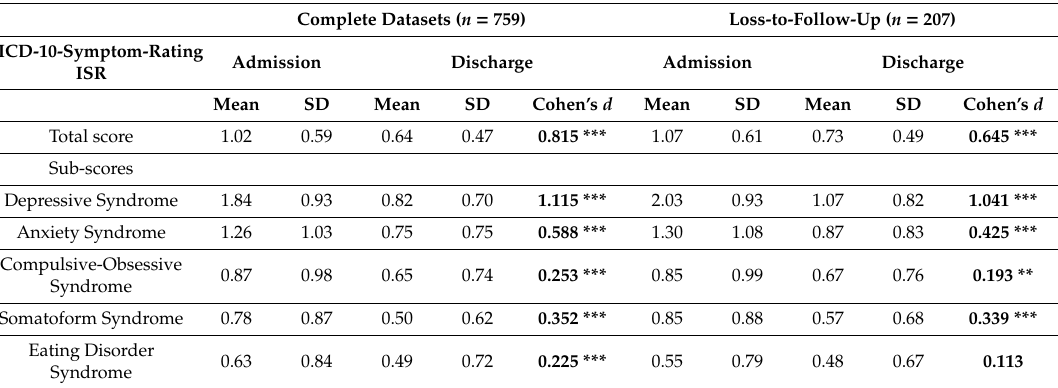
Table 5. Comparison of symptom loads between admission and discharge of 759 patients with complete data sets and of the 207 patients who were lost to follow-up.